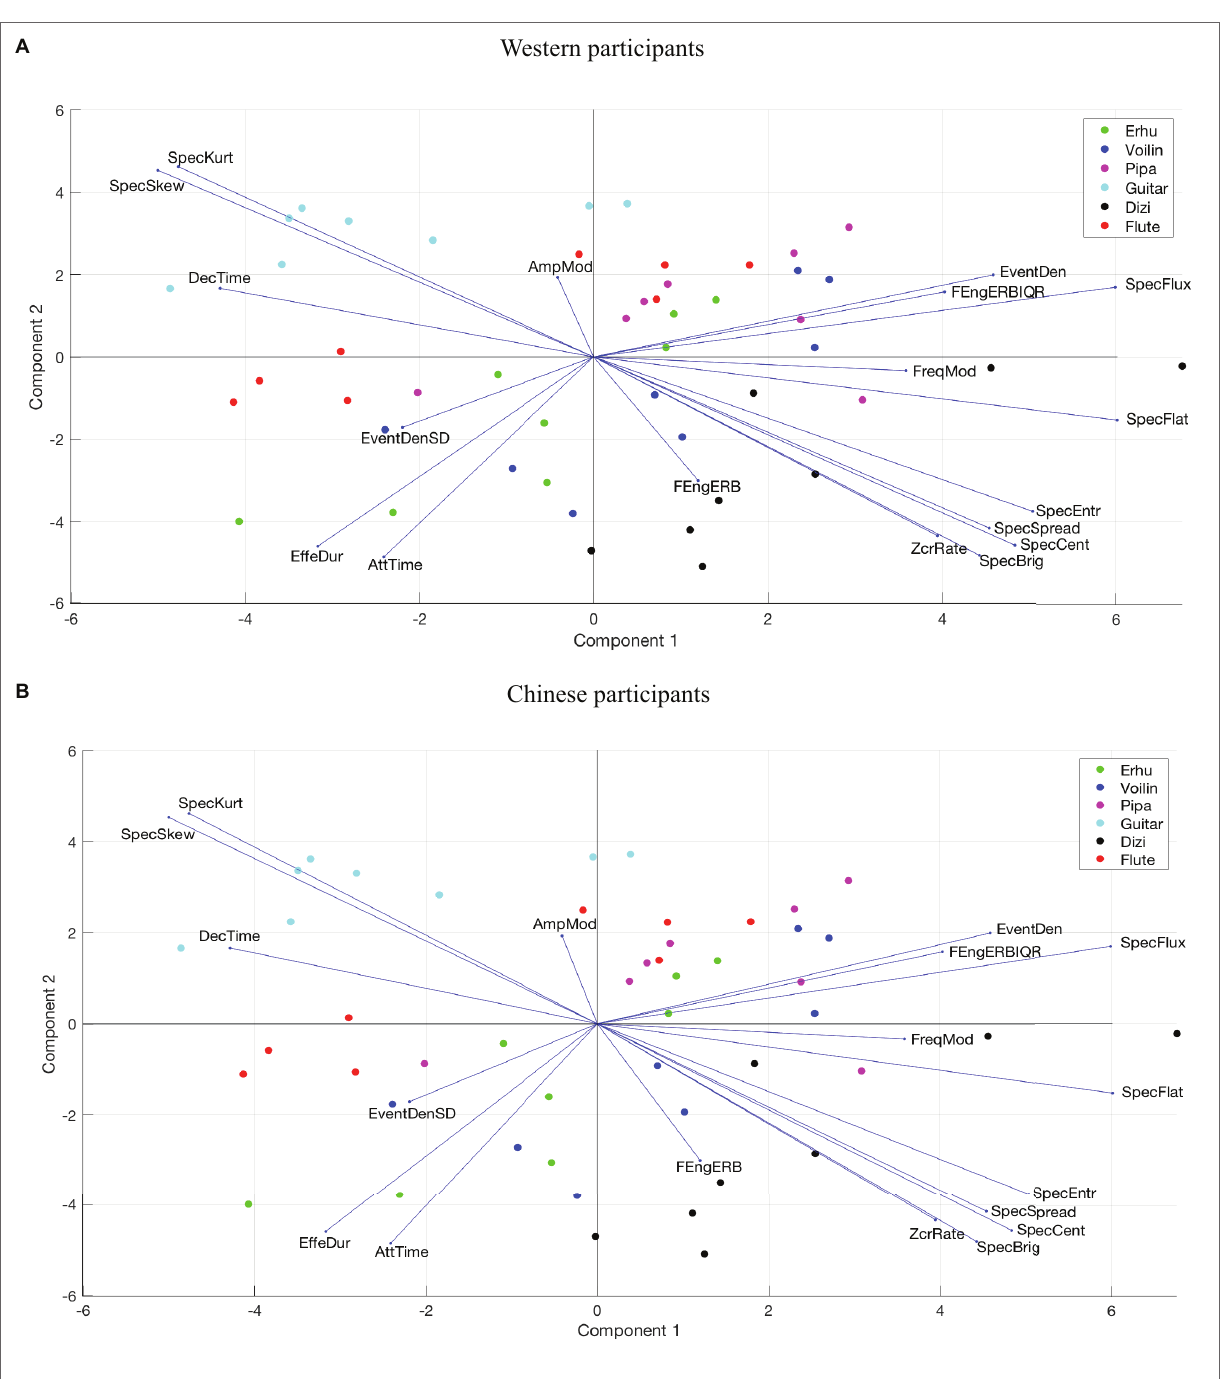
FIGURE 10 | Loadings and scores across two PCs of PLSR for energy arousal. (A) Western participants. (B) Chinese